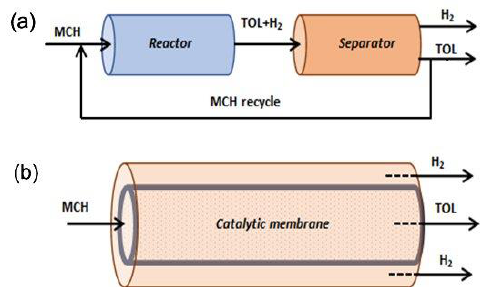
Figure 4. MCH dehydrogenation catalytic membrane reactor systems showing ( a ) a conventional reactor and a separator in series for ex-situ hydrogen separation ( b ) an integrated unit system for in situ hydrogen separation.